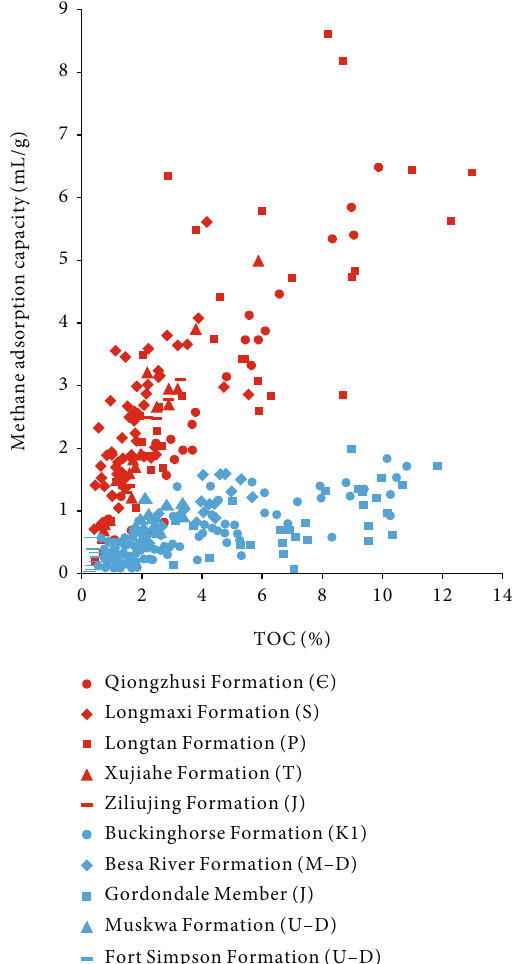
Figure 7: Comparison of shale adsorption capacities of Sichuan Basin and North America. The adsorption capacity of 5 sets of shales in Sichuan Basin is higher than that in North America. (Part of data is from Reference [12, 14]). Red points represented shale adsorption capacities of Sichuan Basin, and blue points represented that of North America. Besides, the era of di ff erent Formation was labelled in following